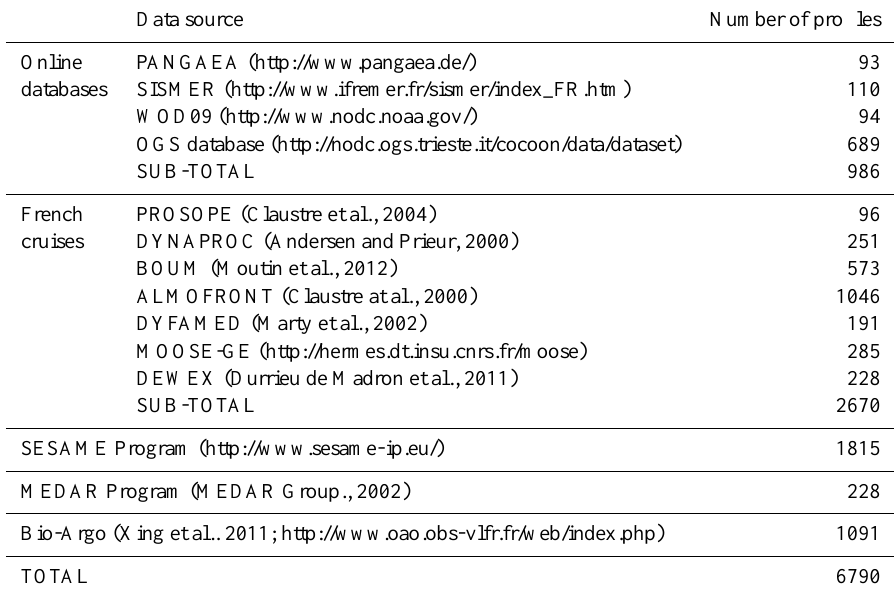
Table 1. Description of sources for fluorescence profiles. In this table, only fluorescence profiles obtained in Mediterranean regions where bathymetry is greater than 100m are counted. Coastal regions have been